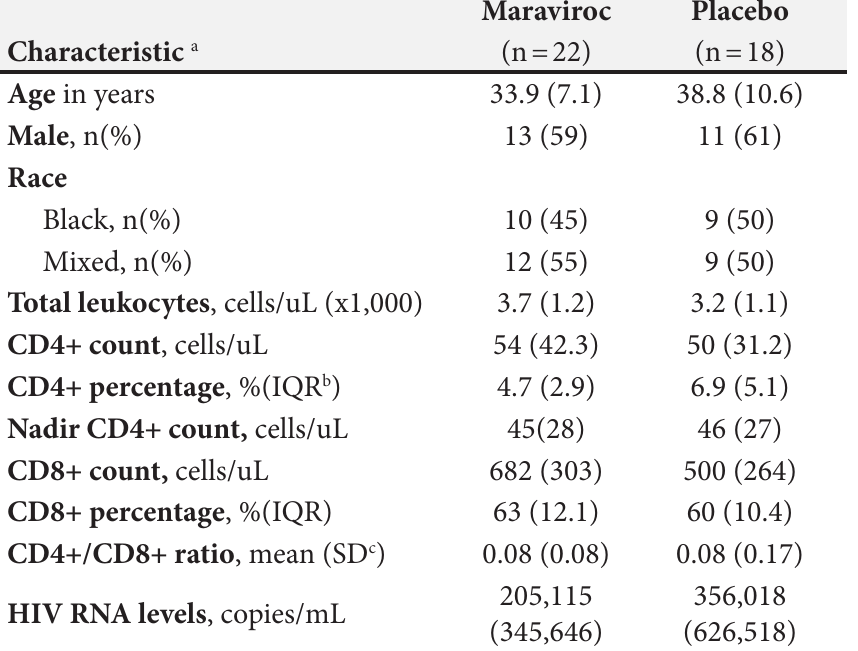
Table 2. Baseline characteristics by treatment